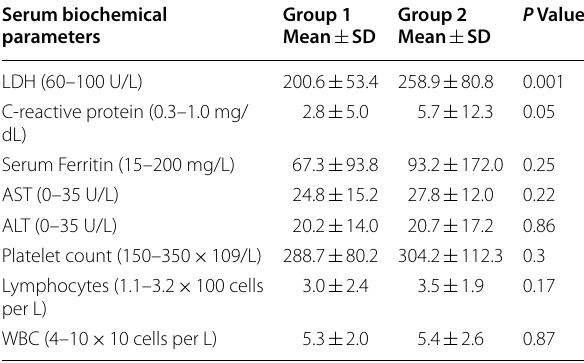
Table 2 Comparison of Serum biochemical parameters in Group 1 (with Normal CXR) Versus Group 2 (with Abnormal